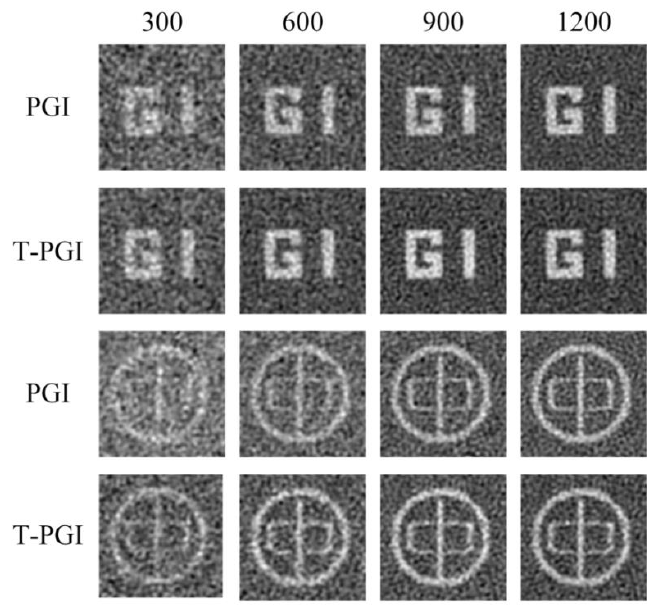
Figure 5. Experimental results for the “GI” and “ZHONG” by the pseudo-inverse ghost imaging (PGI) and T-PGI methods with 300, 600, 900, and 1200 sets of data.